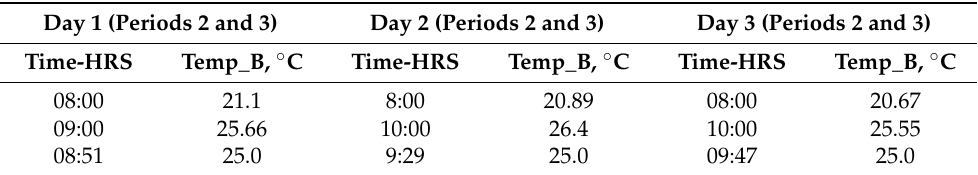
Table 5. Average Temperature of Day 1 (08:00 and 09:00), Days 2 and 3 (08:00 and 10:00) and Estimated Time reaching 25 ◦ C each day.